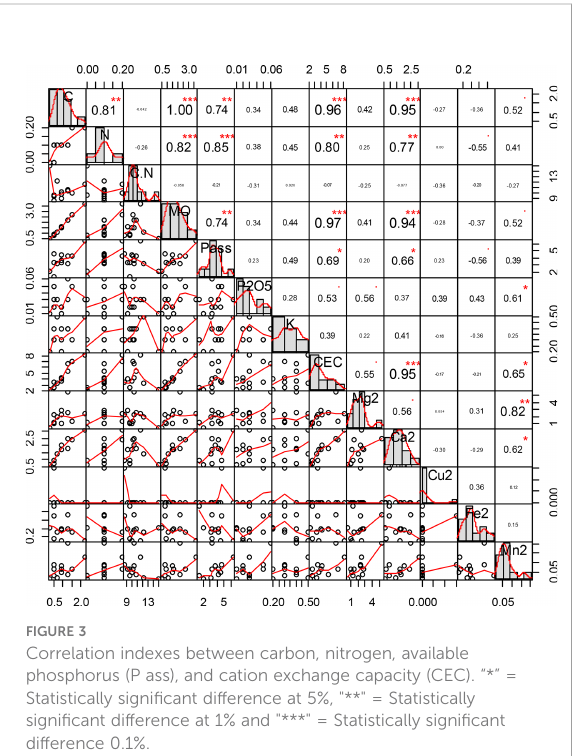
FIGURE 3 Correlation indexes between carbon, nitrogen, available phosphorus (P ass), and cation exchange capacity (CEC). “ * ” = Statistically signi fi cant difference at 5%, "**" = Statistically